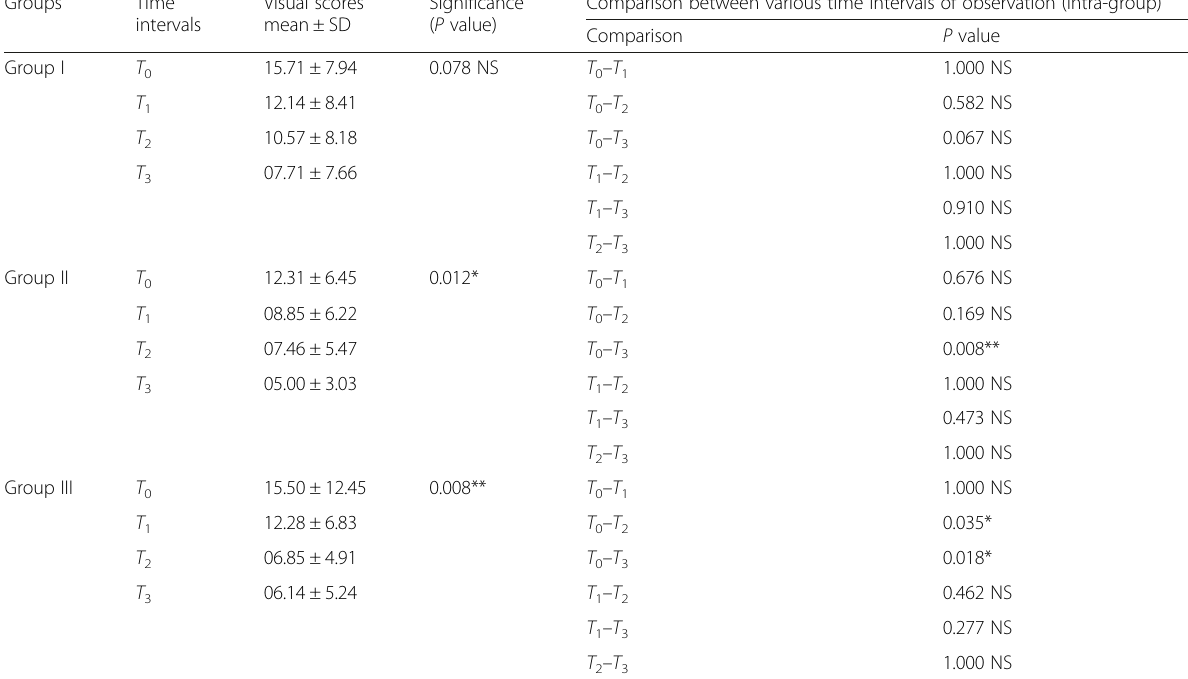
Table 2 Description of visual scores among subjects of three groups at various time intervals of observation Groups Time